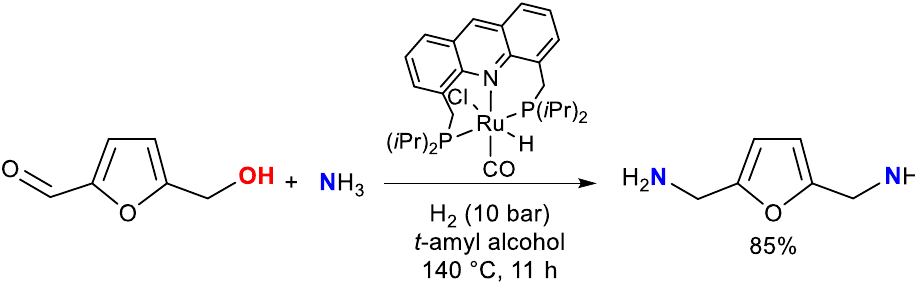
Table 3. Catalytic amination of 5-HMF with ammonia as a nitrogen source to produce 2,5-BAMF.